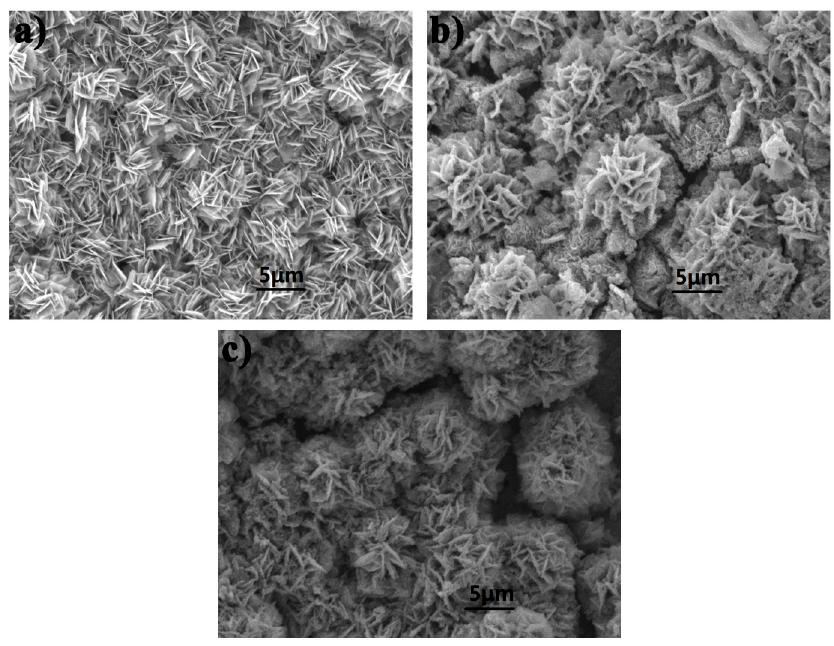
Figure 6. SEM images of samples after 3000 cycles at a current density of 10 A g − 1 , ( a ) Cu–Co oxide; ( b ) P–Cu–Co sulfide; ( c ) O–Cu–Co sulfide.